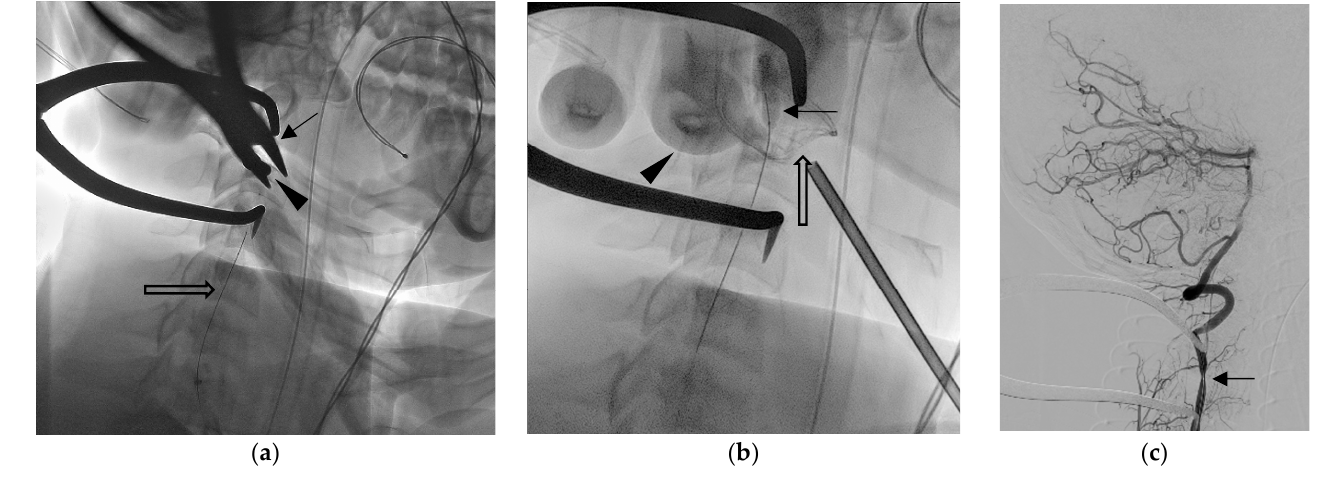
Figure 3. Wound exploration was performed in hybrid operating suite [2]. Fluoroscope images showed the ( a ) surgical plier (arrow) grabbing the arrowhead (arrow), and the occlusion balloon catheter was deployed but not inflated (open arrow). After arrowhead extraction, oozing from the wound was noted. ( b ) The balloon was inflated (arrow) to decrease blood flow while the neurosurgeon applied direct compression (finger imaged, arrowhead) with gauze (open arrow) before performing a further hemostasis procedure. After that, the balloon was released. The following right vertebral angiography ( c ) shows focal narrowing of the artery lumen without extravasation. The patient reported no neurological deficit either when discharged or during their visit to the outpatient clinic 3 months later [3–6].